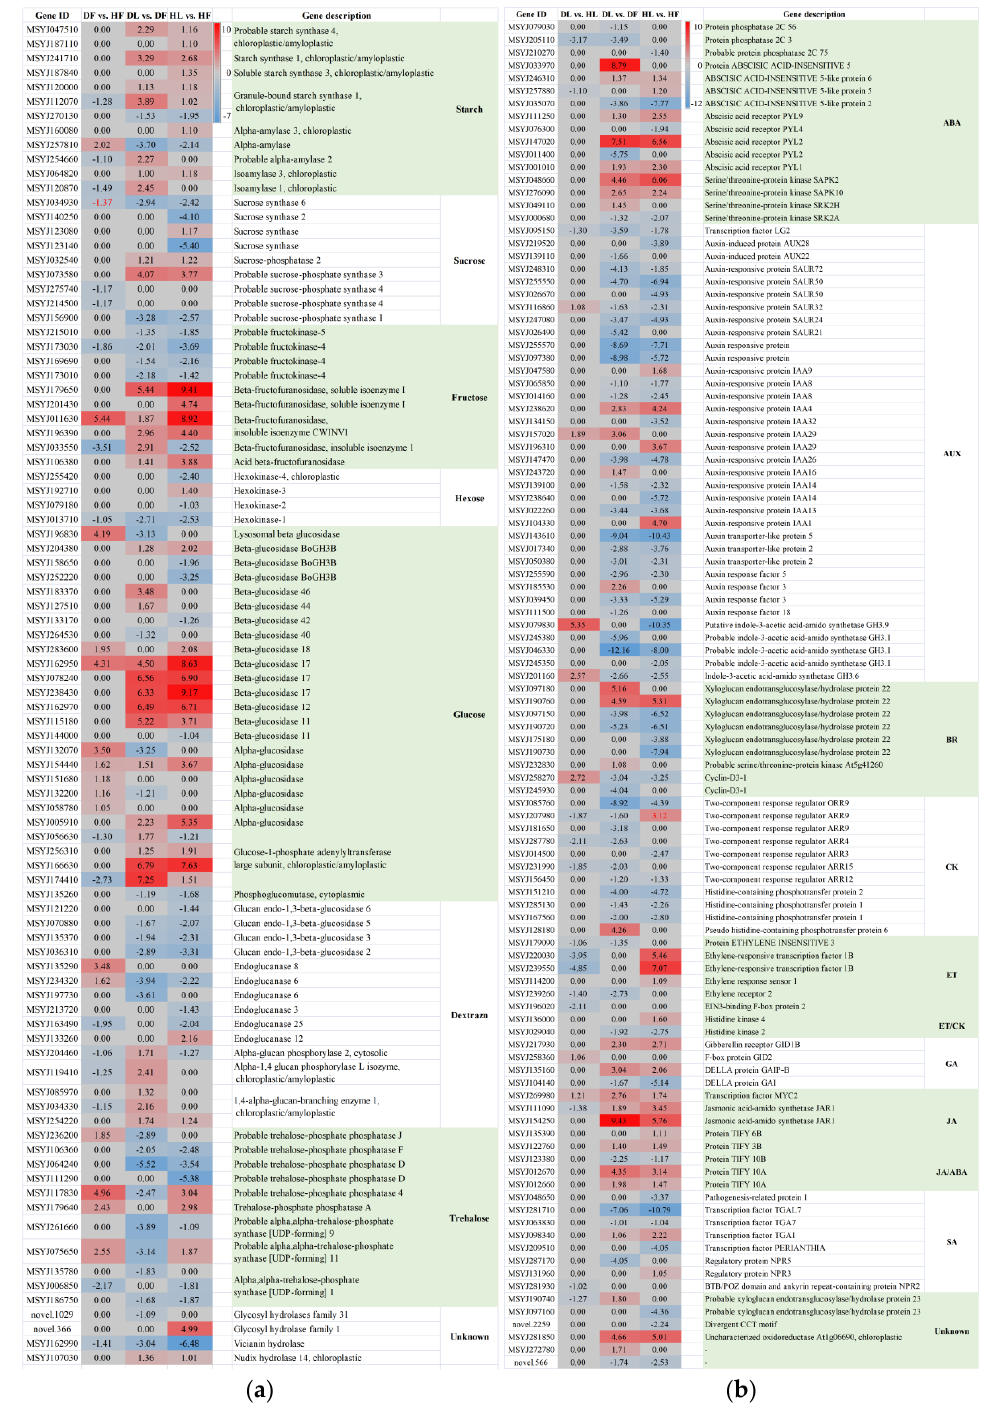
Figure 7. Log 2 Fold change cluster diagram of the differentially expressed genes in the starch and sucrose metabolism pathway ( a ) and plant hormone signal pathway ( b ). DF, diseased fruit pith. DL, diseased leaf. HF, healthy fruit pith. HL, healthy leaf. The color bar represents a range of log 2 Fold change values.